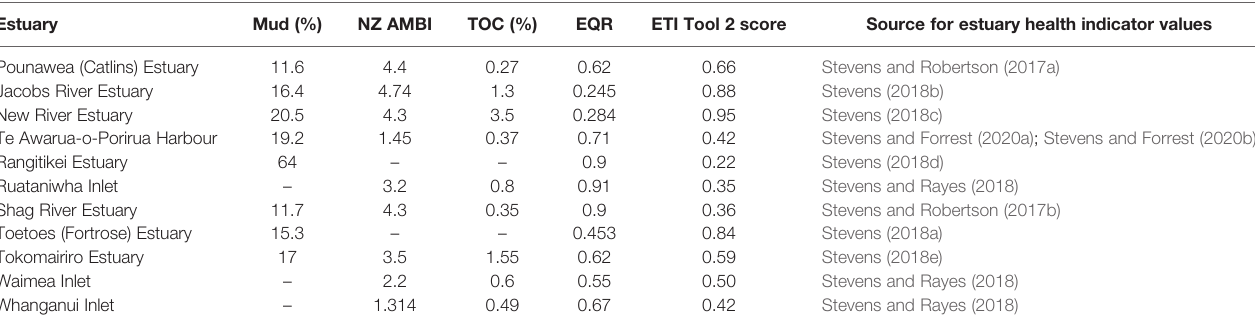
TABLE 3 | Observed estuary health indicator values from 11 NZ estuaries and resulting ETI Tool 2 score.